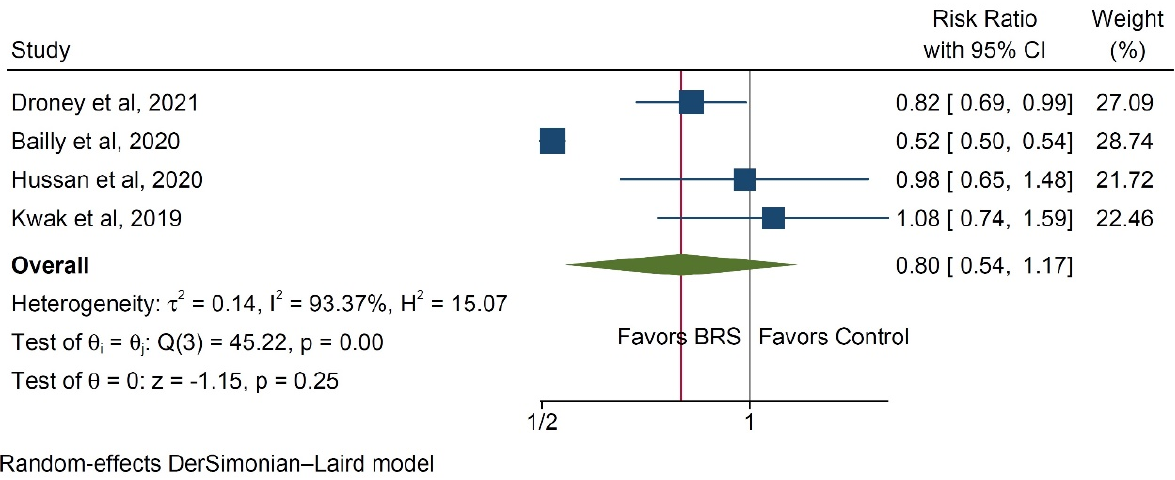
Figure 5. Forest plot of the risk for developing colorectal adenomas [15,20–22].